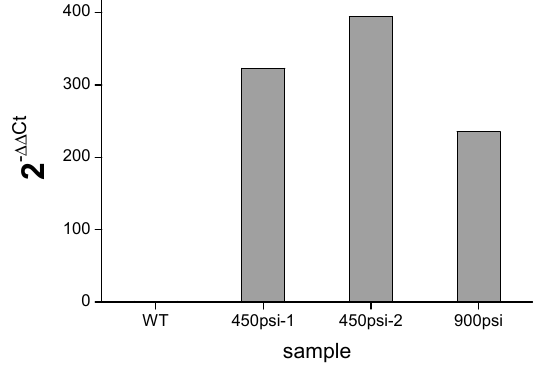
Figure 6. Quantification of the npt Ⅱ gene in three transformants of T. minus through real-time PCR.